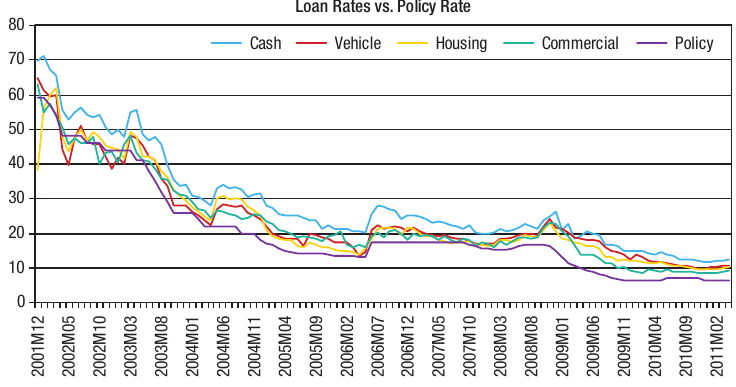
Fig. 1. Loan rates and policy rate in Turkey during 2001M12–2011M04